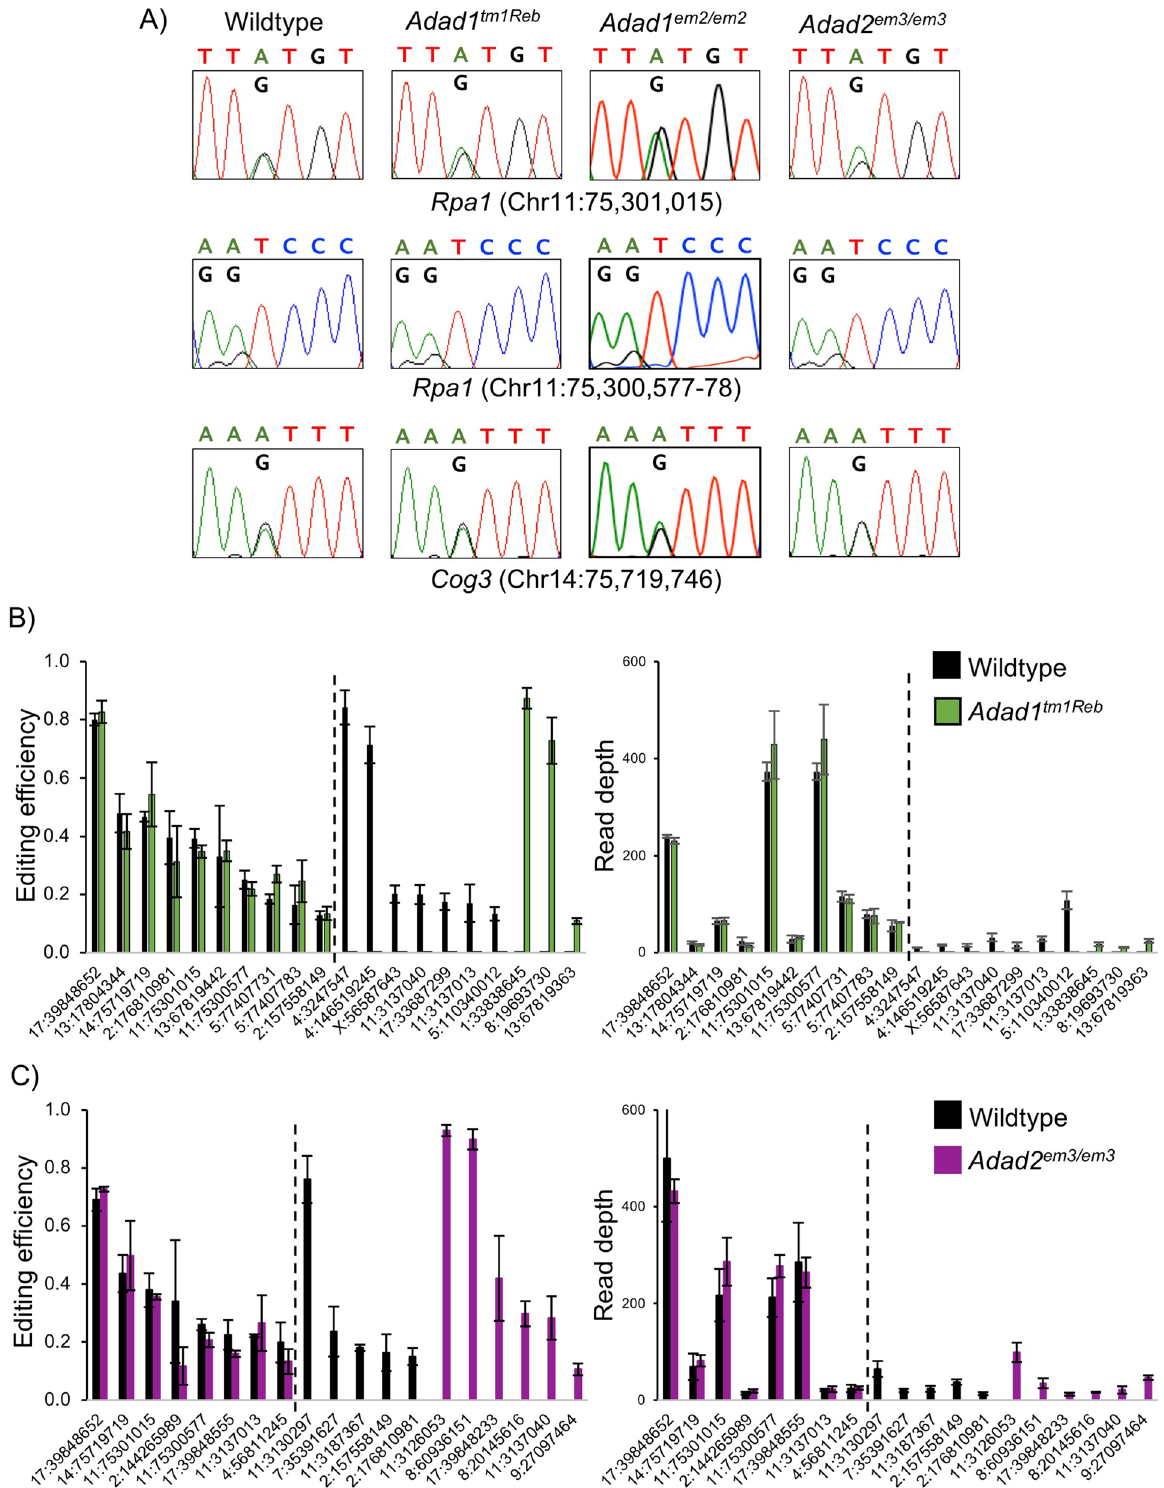
Figure 6. Mutation of Adad1 and Adad2 does not impact RNA editing at known germ cell RNA editing sites nor site selection or efficiency across the transcriptome. ( A ) Sanger sequencing chromatographs of known germ cell A-to-I RNA editing sites in adult wildtype, homozygous Adad1 mutant, and homozygous Adad2 mutant testes. All Rpa1 sites detected in both spermatocytes and spermatids. Cog3 site detected only in spermatocytes. Mixed A/G peaks indicate A-to-I editing sites. No significant changes in peak height were observed in mutant versus wildtype testes. N ≥ 3. Representative chromatographs shown. ( B ) and ( C ) RNA editing efficiency (fraction of edited reads) at all detected sites in ( B ) Adad1 wildtype and mutant and ( C ) Adad2 wildtype and mutant. Read depth (number of informative reads) for each site shown. Dashed lines demarcate genotype-independent and genotype-dependent events. Only sites detected in all three replicates of a given genotype were considered for analysis. N = 3, error bar—standard